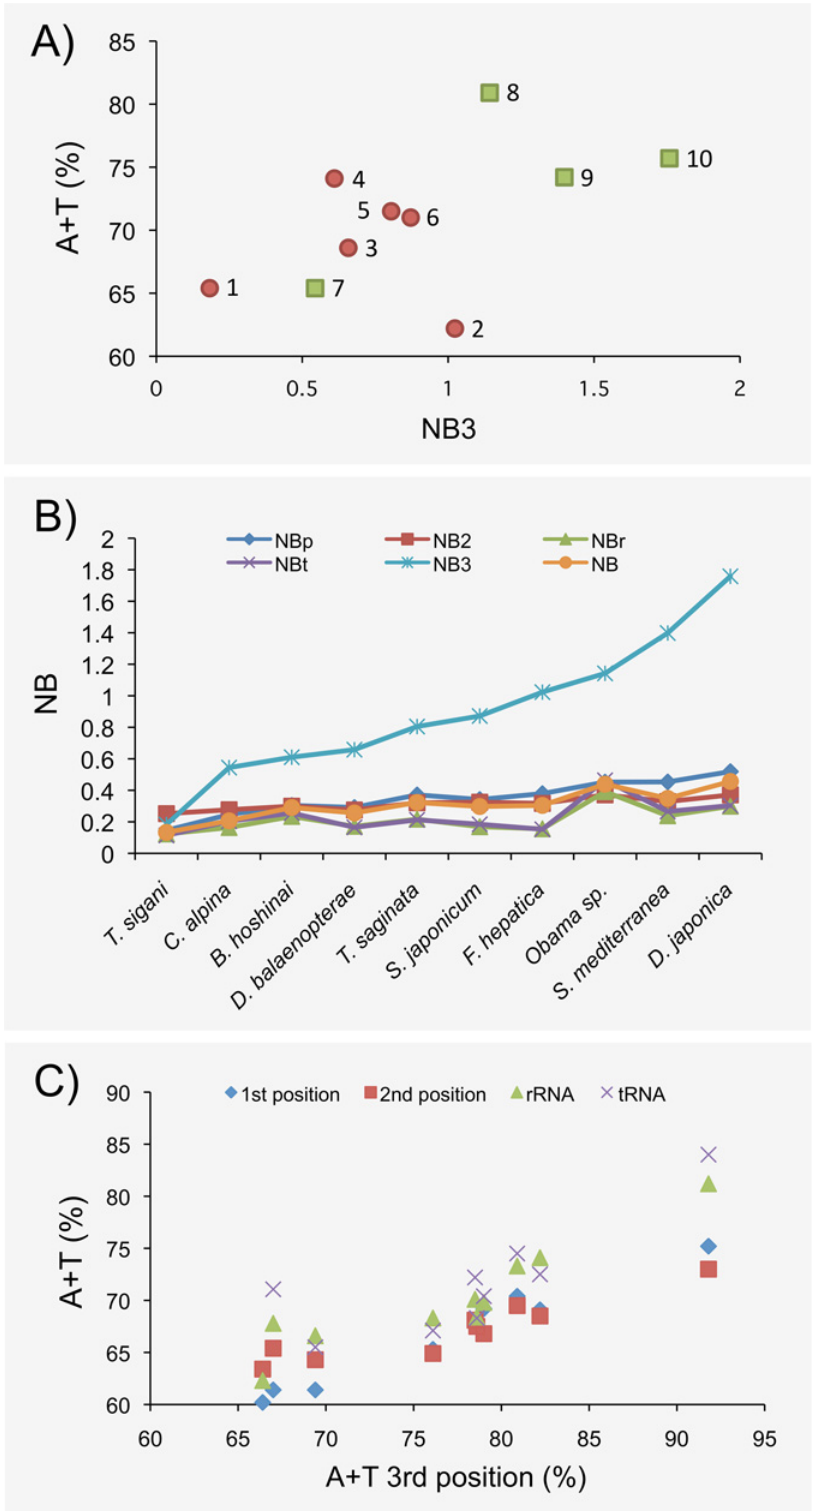
Fig 3. Nucleotide composition bias in the Platyhelminthes analyzed. A) Relationship between A+T content and NB3 (NB at the third position of four-fold degenerate codons) values. Green squares and